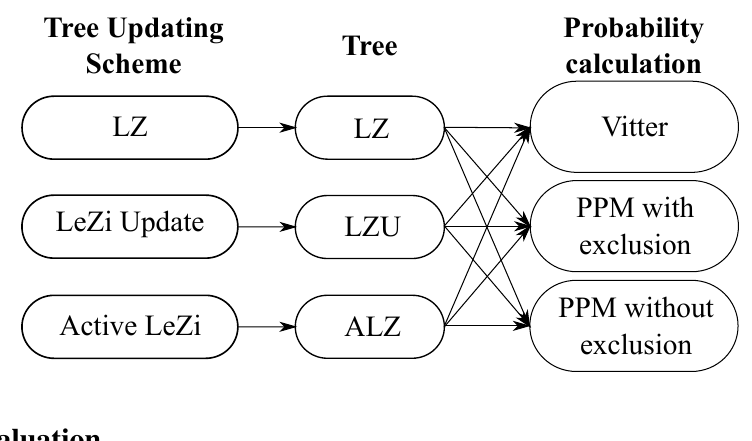
Figure 2. Combinations of the two independent